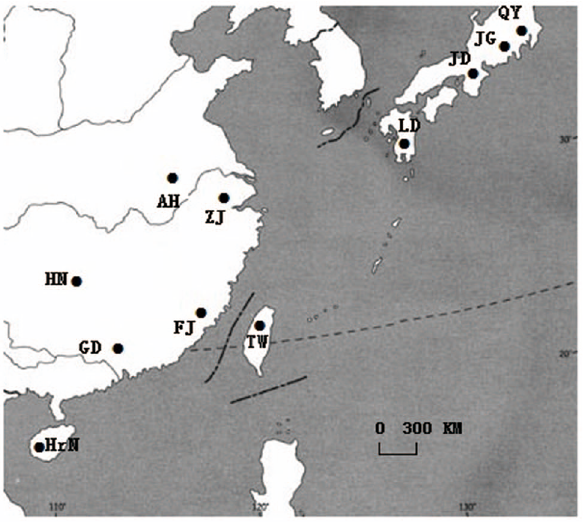
Fig. 1. The distribution map of eleven tea green leafhopper populations. Six populations were sampled from Anhui (AH), Zhejiang (ZJ), Hunan (HN), Fujian (FJ), Guangdong (GD) and Hainan (HrN) in main tea production regions of Mainland China. One population was collected from Taiwan, and four populations were collected from Shizuoka (JG), Kyoto (JD), Saitama (QY) and Kagoshima (LD) in Japan.